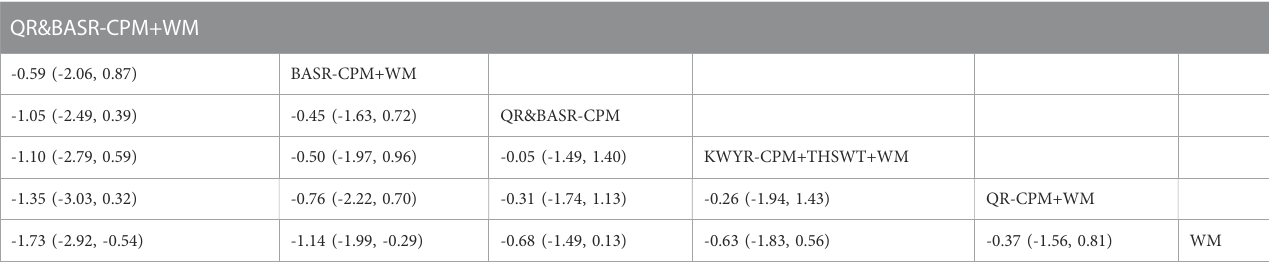
TABLE 8 Results of network meta-analysis for LVMI.